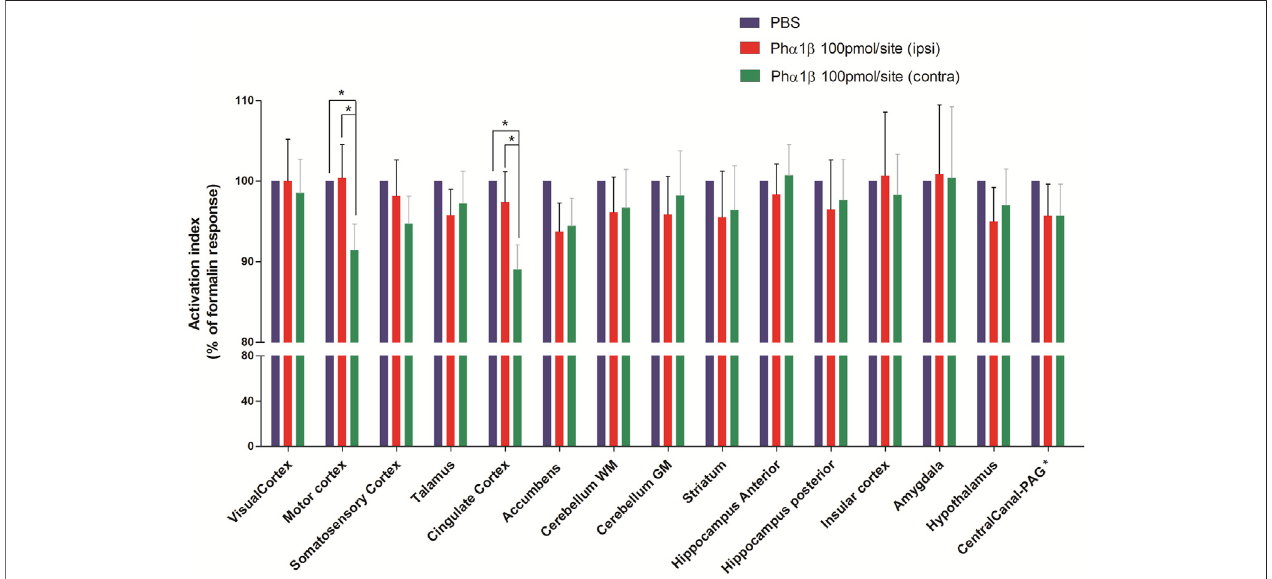
FIGURE4| EffectofpretreatmentwithPh α 1 β toxinonmetabolicchangesindifferentbrainareasofratsinducedbyformalin.Barsrepresentmean+S.E.M. 18 F-FDG uptake normalised by the 18 F-FDG uptake in the group that received intrathecal PBS. Pretreatment with intrathecal Ph α 1 β (100 pmol/site) led to a reduction in the metabolic activity in some neuroanatomic regions, notably in the cingulate cortex and motor cortex. The de fi nition of contra or ipsilateral was made in reference to the right paw where formalinor PBSwas administered (N (cid:1) 6 and N (cid:1) 10; PBS and Ph α 1 β , respectivelly).* denotes p < 0.05, Factorial ANOVAs withFisher ’ s post hoc tests). WM: white matter, GM: gray matter, PAG: periaqueductal